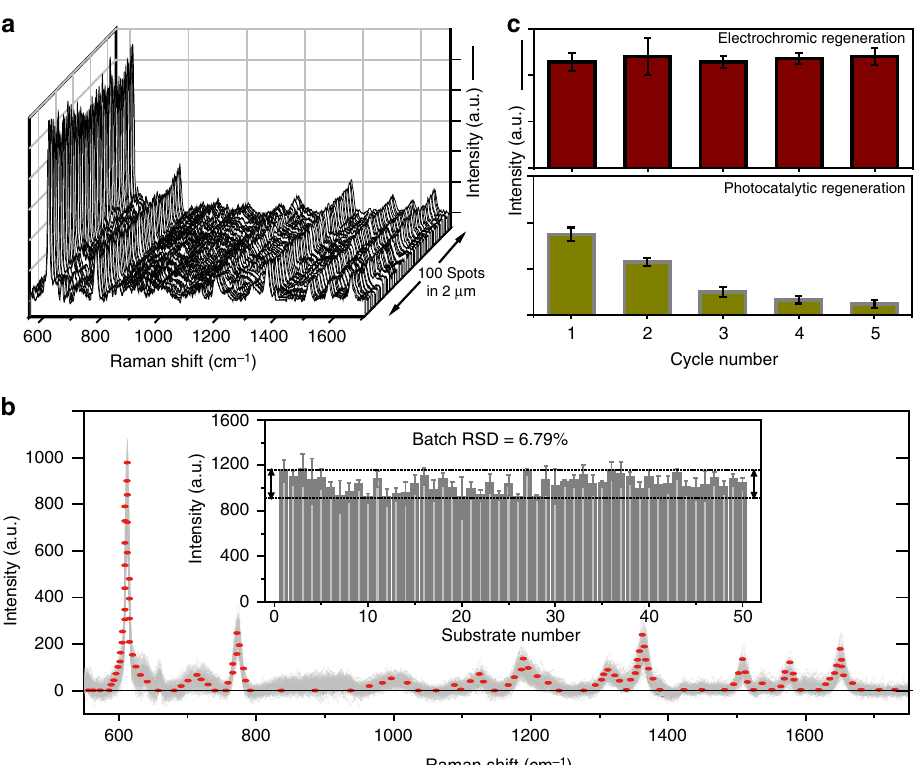
Fig. 3 High reproducibility and renewability. a Surface-enhanced Raman scattering (SERS) spectra in the line-scan across a randomly selected area on the surface of single Al-5 substrate, taken with a 20 nm step size (scale bar: 200 cps). b SERS spectra of 10 − 4 M rhodamine 6G (R6G) collected from 500 randomly selected positions on 50 batches of Al-5 substrates, with the overlapped signals forming a shaded area as outlined in red. Inset shows the batch- to-batch Raman intensity variation for the 612 cm − 1 vibrational band measured for these 50 batches of Al-5 substrates. c Comparison between SERS intensity of the 612 cm − 1 vibrational band of single substrates used for multiple cycles, renewed either through electrochromic or photocatalytic methods (scale bar: 400cps). Error bars represent means ± SD of the SERS